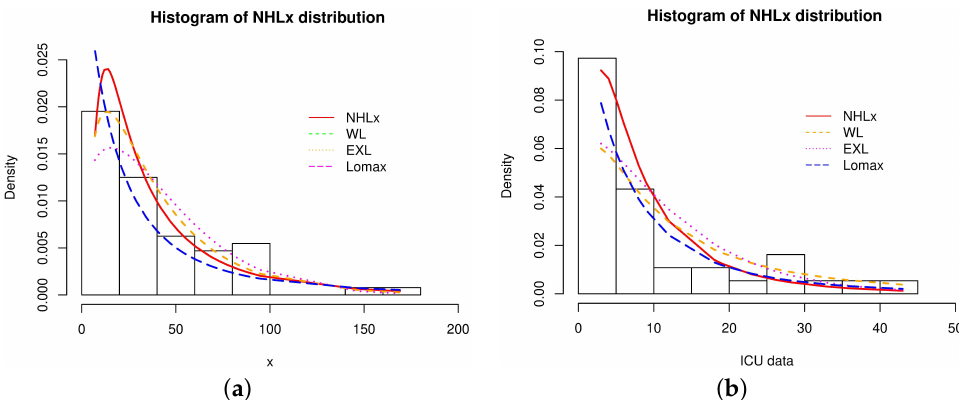
Figure 3. Curves of the estimated pdfs of the considered models for the two data sets. ( a ) Eruption data. ( b ) ICU